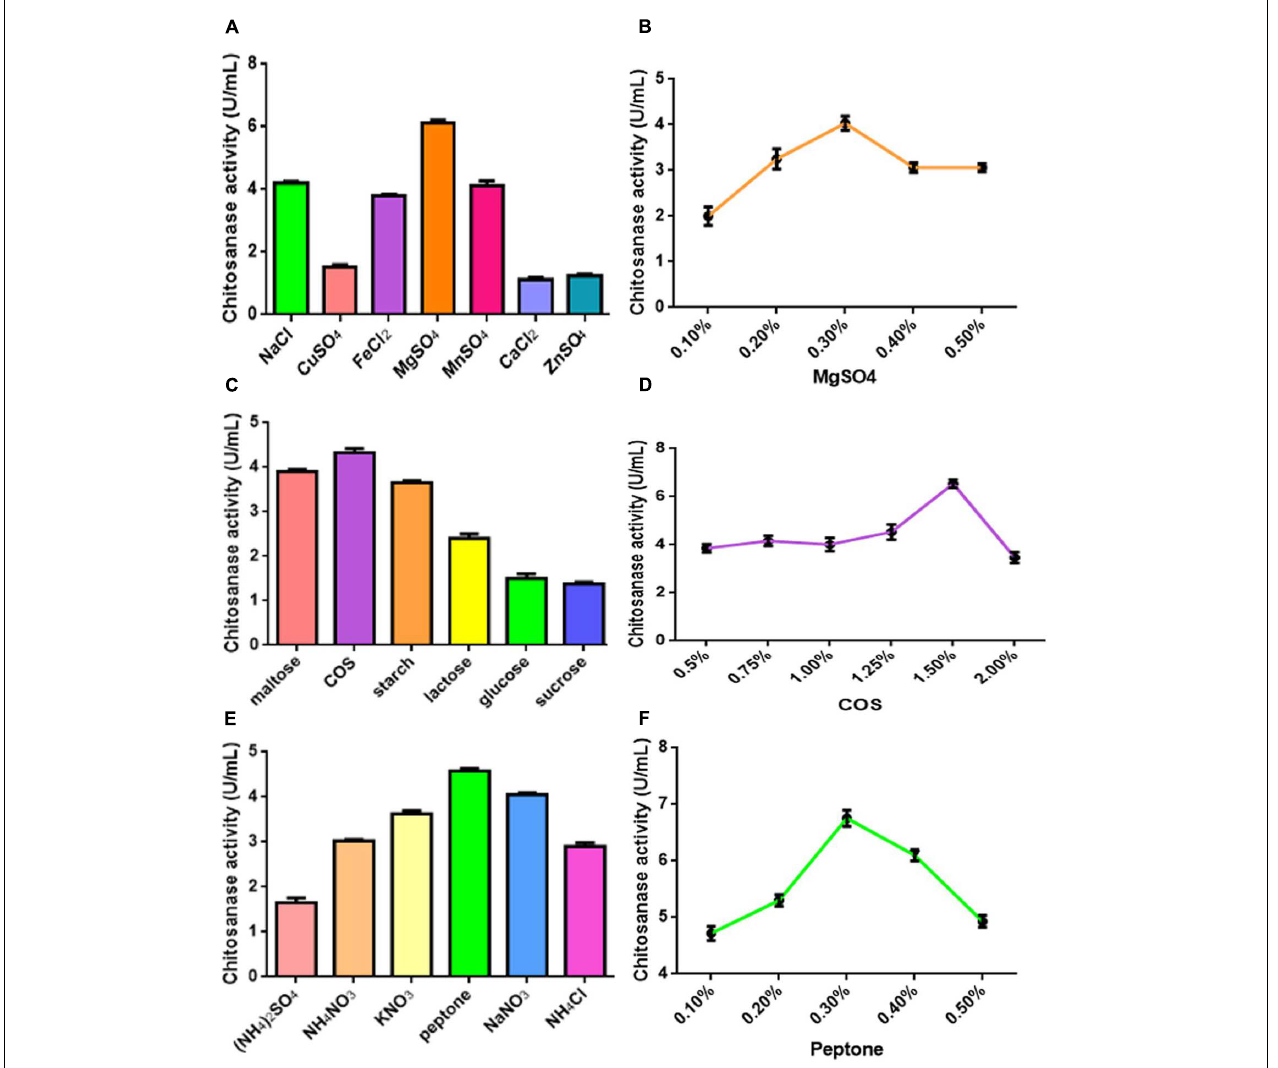
FIGURE 2 | (A) Effect of different kinds of metal ions on COSE activity. (B) Effect of different concentrations of MgSO 4 on COSE activity. (C) Effect of carbon source on COSE activity. (D) Effect of different concentrations of COS on COSE activity. (E) Effect of nitrogen sources on COSE activity. (F) Effect of different concentrations of peptone on COSE